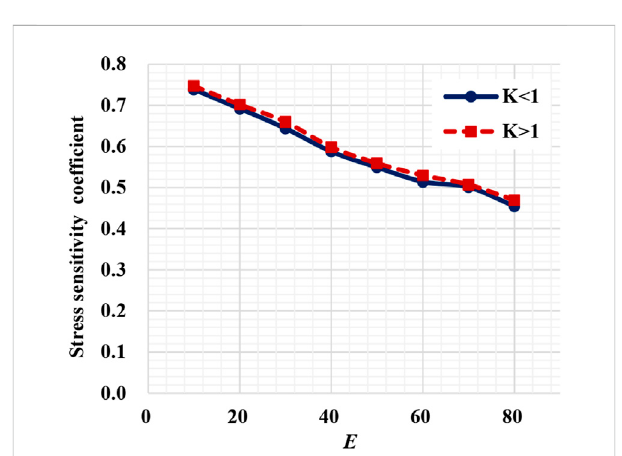
FIGURE 11 Variation of stress sensitivity coef fi cient against the elastic